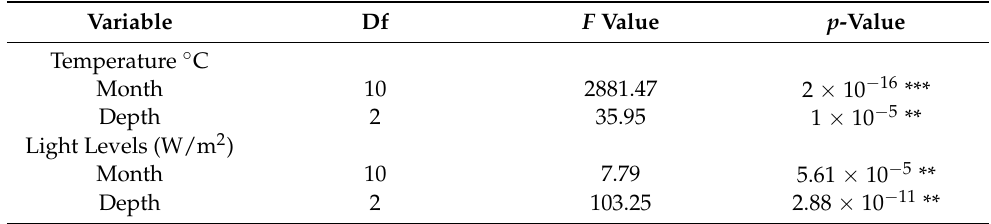
Figure 5. Comparison of temperatures ( A ), and ( B ) light levels (measured during the first ten days of every month), from farms set at shallow (5 m, in red), medium (8, in green) and deep (12 m, in blue) depths. Bars represents monthly average and whiskers standard error. Table 1. Two-way ANOVAs results between Seawater Temperature (ST) and Light Level (LL). ** and *** represent levels of